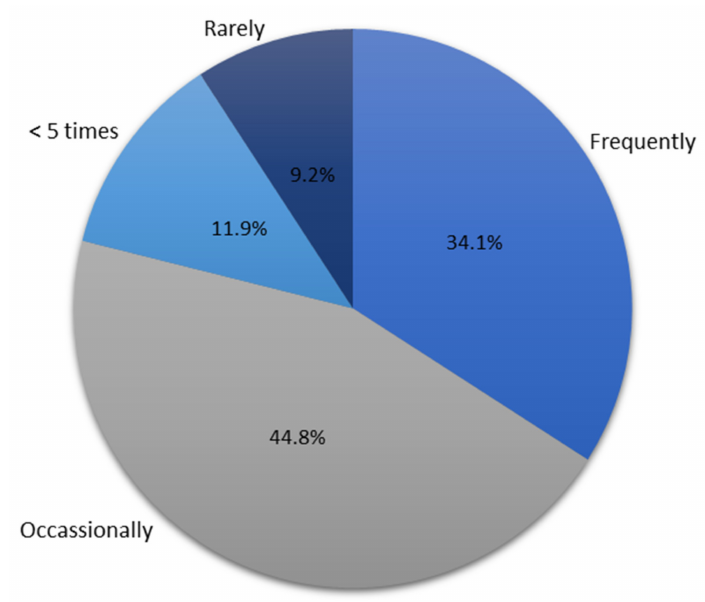
Figure 5. Frequency of wreck